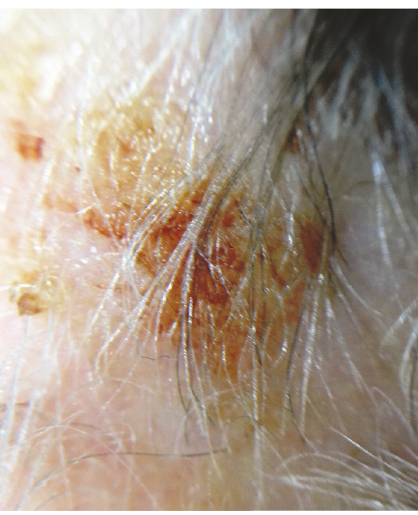
Figure 1: Clinical examination found multiple scalp erosions and crusted plaques.